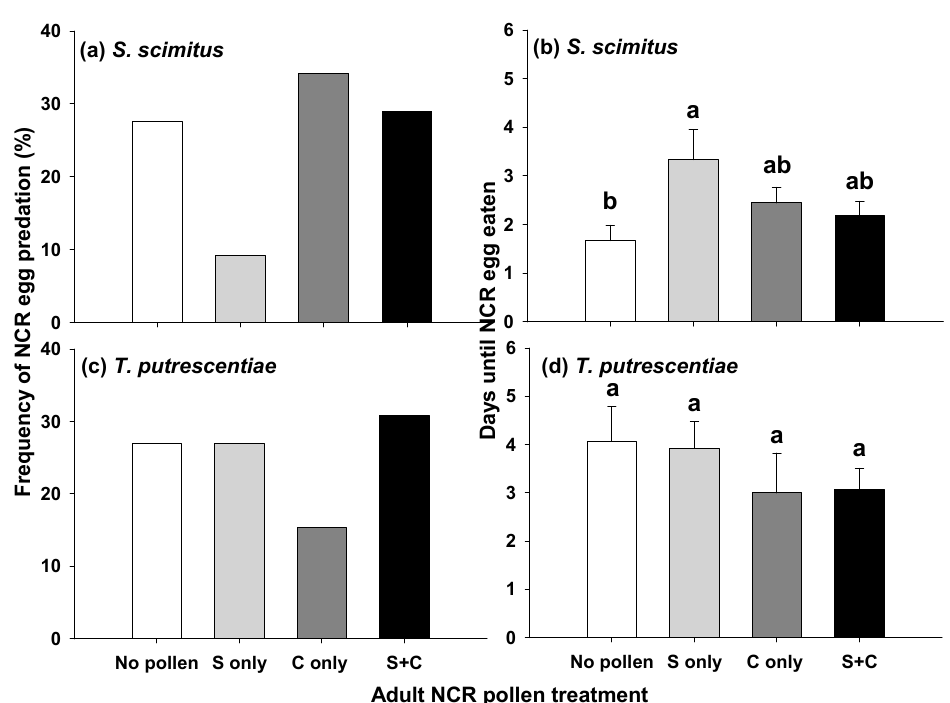
Figure 3. Impact of adult NCR pollen feeding on frequency of NCR egg predation for ( a ) S. scimitus and ( c ) T. putrescentiae ; and days until an NCR egg was eaten by ( b ) S. scimitus and ( d ) T. putrescentiae . S = sunflower pollen only, C = corn pollen only, S + C = sunflower + corn pollen. Means with the same letters are not significantly different ( α = 0.05).